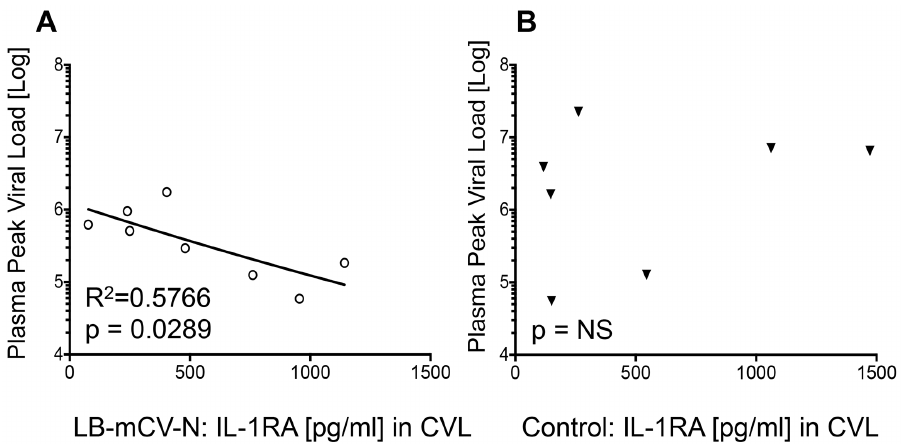
Figure 4. Higher mucosal IL-1RA was predictive of lower peak viral load. Macaques that were colonized with LB-mCV-N and experienced breakthrough infection had 6-fold lower viral loads than control macaques [29]. Mucosal IL-1RA was measured during SHIV challenge prior to infection and the average value was plotted against the peak viral load. We found that higher levels of mucosal IL-1RA prior to infection were correlated with a lower peak viral load. A) Levels of mucosal IL-1RA [pg/ml], found in CVLs of macaques colonized with LB-mCV-N, were inversely correlated with peak plasma viral load, thus higher IL-1RA prior to infection correlated with lower viral load B) No correlation with peak plasma viral load was found in mucosal IL-1RA, found in CVL of uncolonized control macaques.